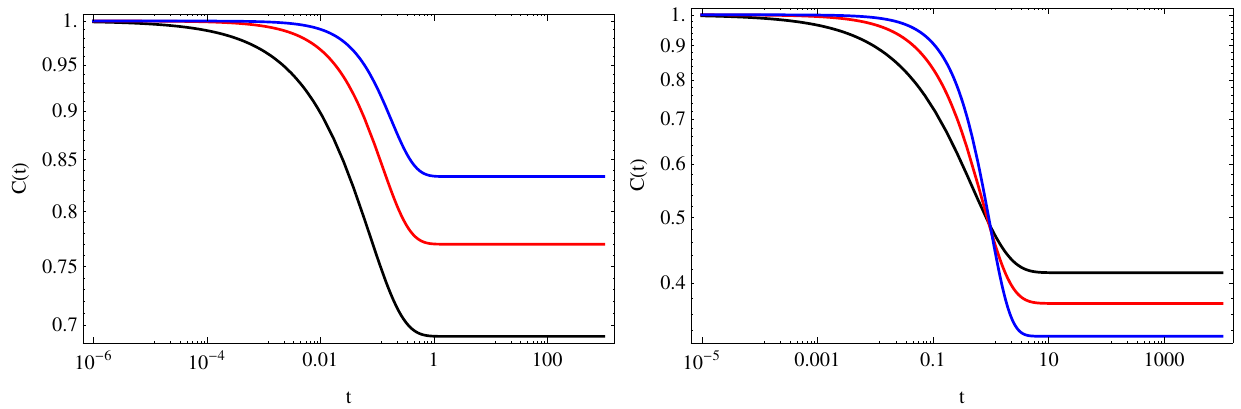
Figure 6. Behaviour of the correlation function (69) for Cole–Cole relaxation with resetting. The parameters are taken as follows: λ 1 = 1, τ = 1 and α = 1 (Debye relaxation with resetting, blue line), α = 3/4 (red line), α = 1/2 (black line). Left panel : r = 5; Right panel : r =